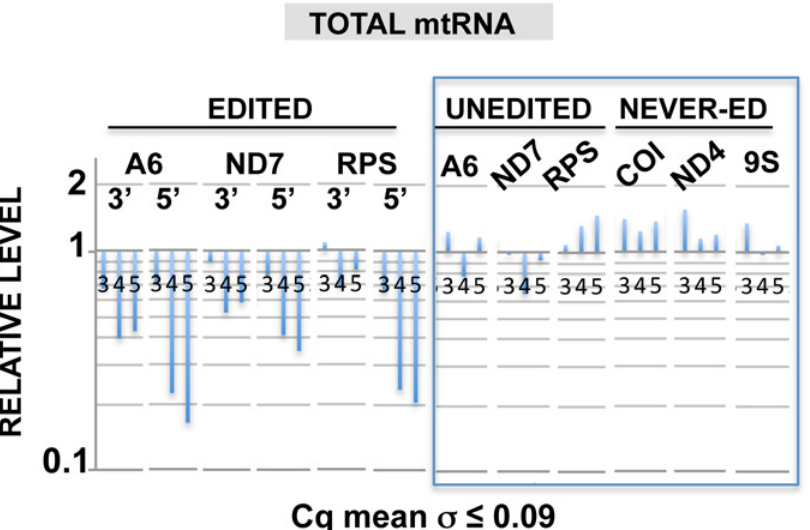
Fig 4. REH2 knockdown affects editing progression. (A) RT-qPCR of steady-state edited mRNA at block 1 in mRNAs A6 and ND7, and the first few blocks in RPS12 (3 ’ sites) or a distal block (5 ’ sites), unedited or never-edted RNAs at days 3, 4, and 5 of REH2 RNAi. Uninduced samples are set at 1.